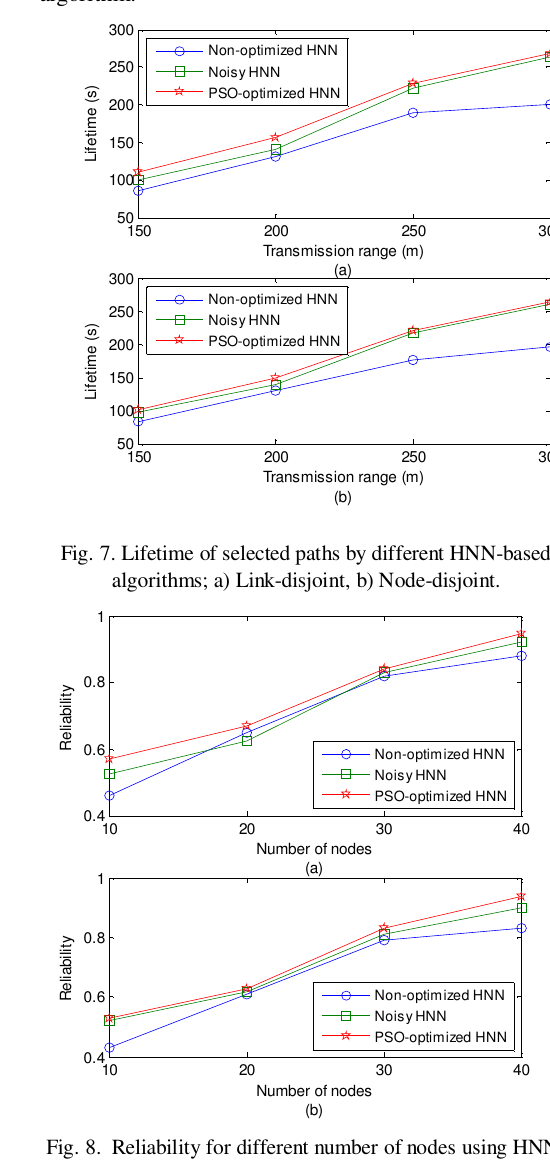
Fig. 6. Number of paths selected by different HNN-based algorithms; a) Link-disjoint, b) Node-disjoint.